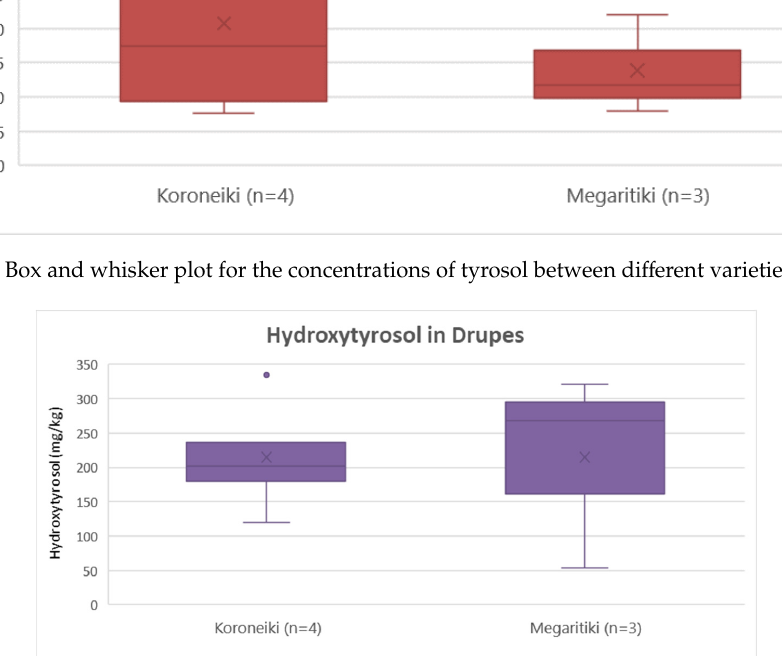
Figure 12. Box and whisker plot for the concentrations of hydroxytyrosol between di ff erent varieties of drupes.